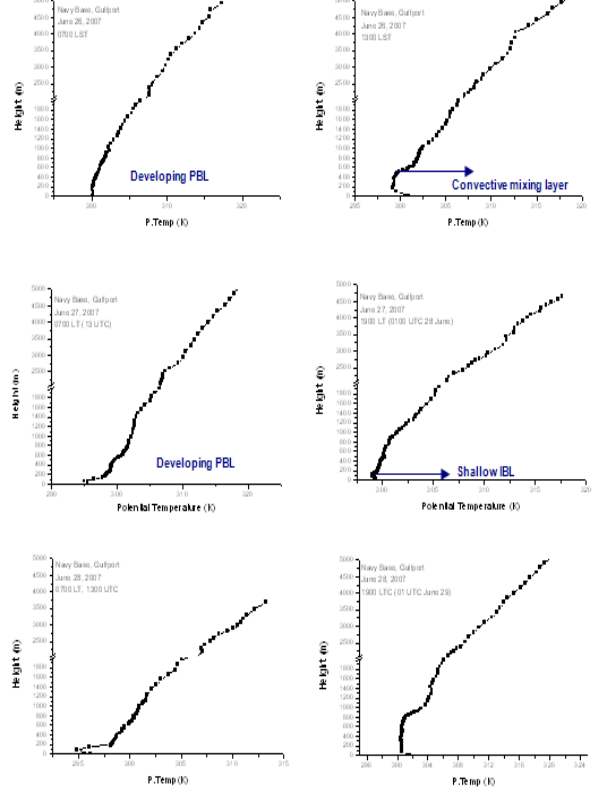
Figure 4: GPS sonde potential temperature profiles for Sea Bee Base for 27 and 28 June 08.